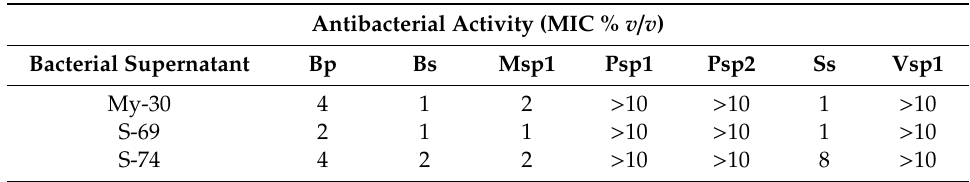
Table 4. Bacterial supernatants e ff ect on growth inhibition of marine bacteria involved in biofilm formation. Results are expressed as Minimum Inhibitory Concentration (MIC)